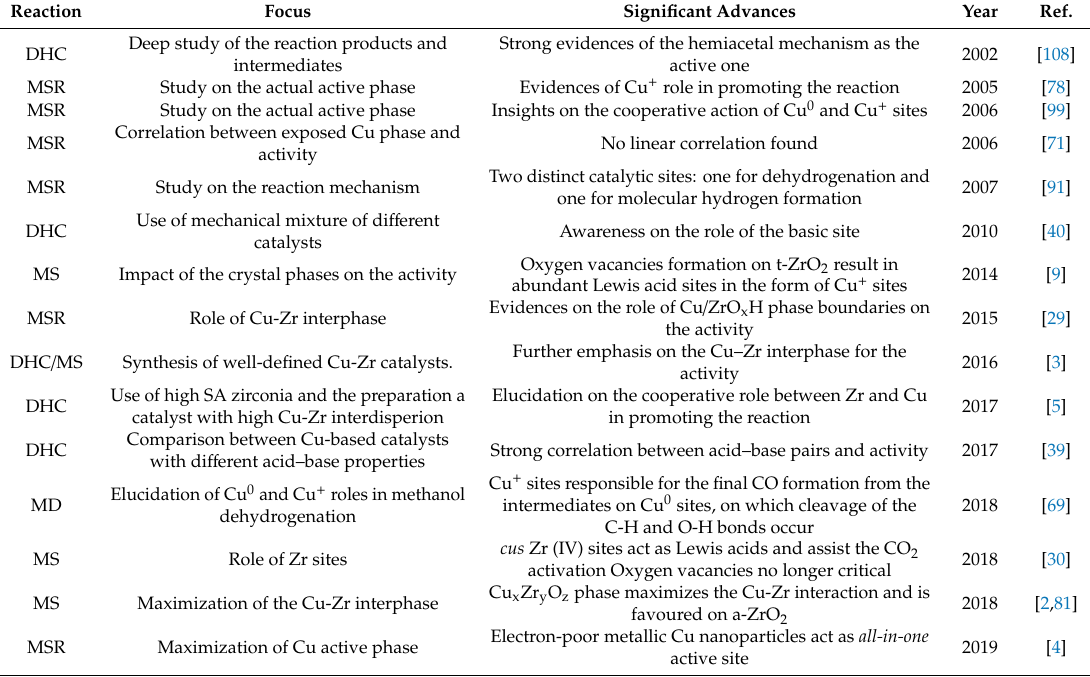
Table 3. Significant advances in the comprehension of copper–zirconia catalysts (MS =